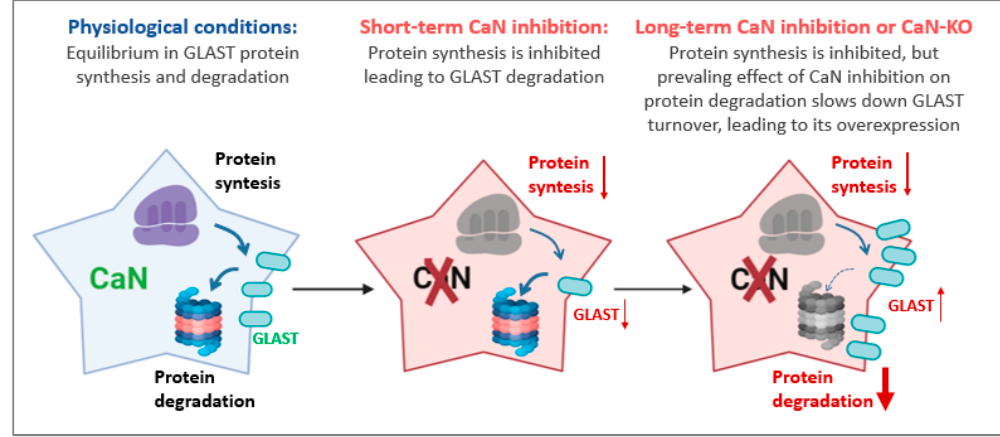
Figure 6. Scheme of the proposed mechanism for the time-dependent dynamic modulation of GLAST protein expression upon inhibition of CaN in astrocytes. Left astrocyte, protein synthesis and protein degradation are in equilibrium maintaining constant expression of GLAST. Middle astrocyte, short-term CaNinhibitionbyFK506resultsinaprevalentinhibitionofproteinsynthesisresultingindownregulation of GLAST. Right astrocyte, long-term pharmacological CaN inhibition or knock-out of CaN in astrocytes result in prevailing e ff ect on the inhibition of protein degradation over the inhibition of protein synthesis, resulting in slowing down the GLAST turnover and its accumulation. The time-dependent e ff ect of CaN inhibition on dynamics of other proteins in the cell may di ff er from that of